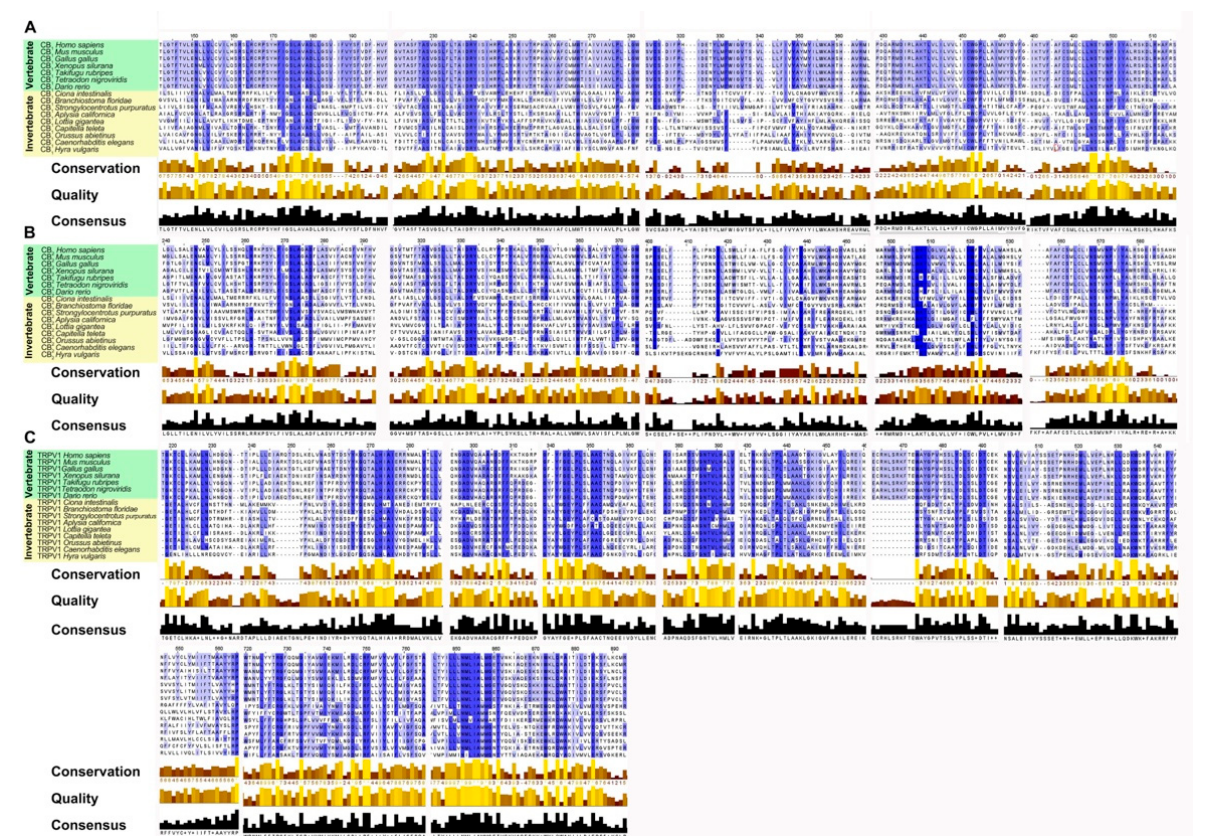
Figure 4. Alignment of multiple sequences of the functional orthologs of cannabinoid receptors (CB 1 , CB 2 , TRPV1) of 15 different species generated by Tcoffell. The refinements were carried out with the Jalview software. For better comparability, all sequences were shortened to emphasize the conserved domains. The highlighted boxes represent a preserved pattern and the intensity of the blue color is related to the degree of conservation. In addition, the conservation, quality (yellow to brown bars) and consensus (black bars) sequences are shown. ( A ) Alignment of functional orthologs of the CB 1 receptor. ( B ) Alignment of functional orthologs of the CB 2 receptor. ( C ) Alignment of functional orthologs of the TRPV1 receptor.